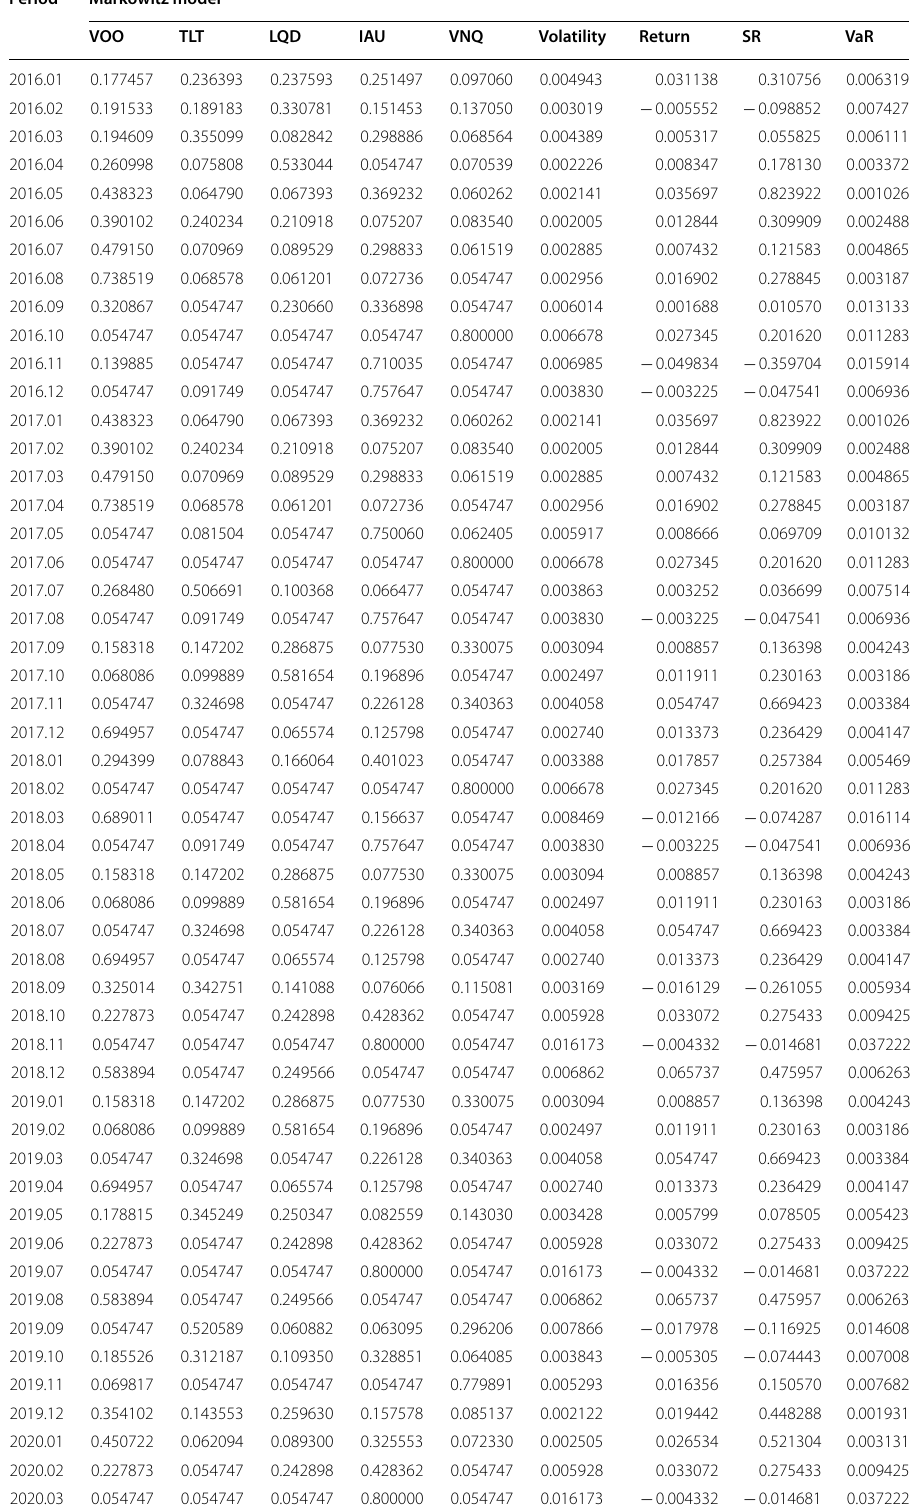
Table 4 The out‑of‑sample results of Markowitz model and semiparametric method with VaR